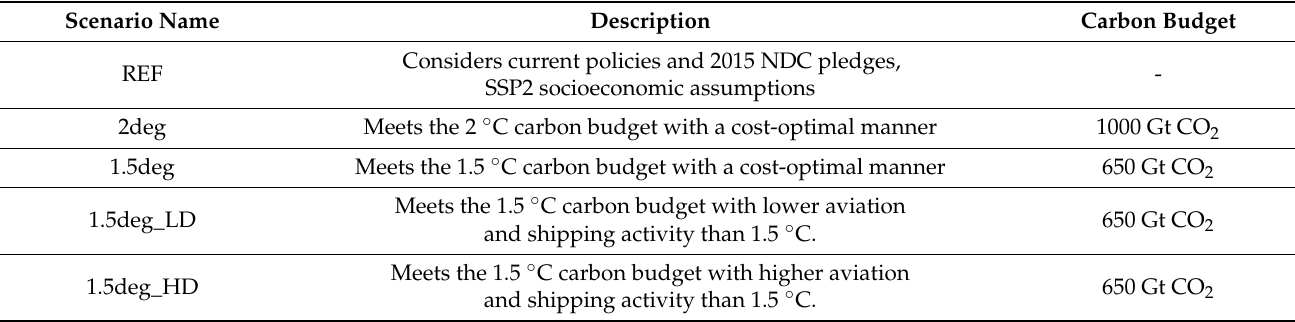
Table 1. Scenario assumptions used in the